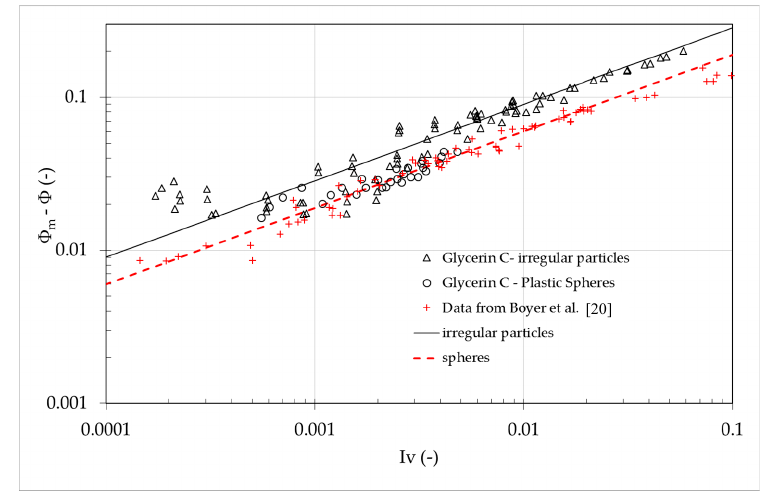
Figure 12. Plastic irregular particle–glycerin C solution. ( Φ m − Φ ) as a function of I v compared with the experimental results for the plastic sphere–glycerin C solution and the data reported by Boyer et al. [20] for viscous suspensions with spheres (solid lines depict the power law behavior for irregular particles-black solid line- and spheres-red dashed line-respectively).